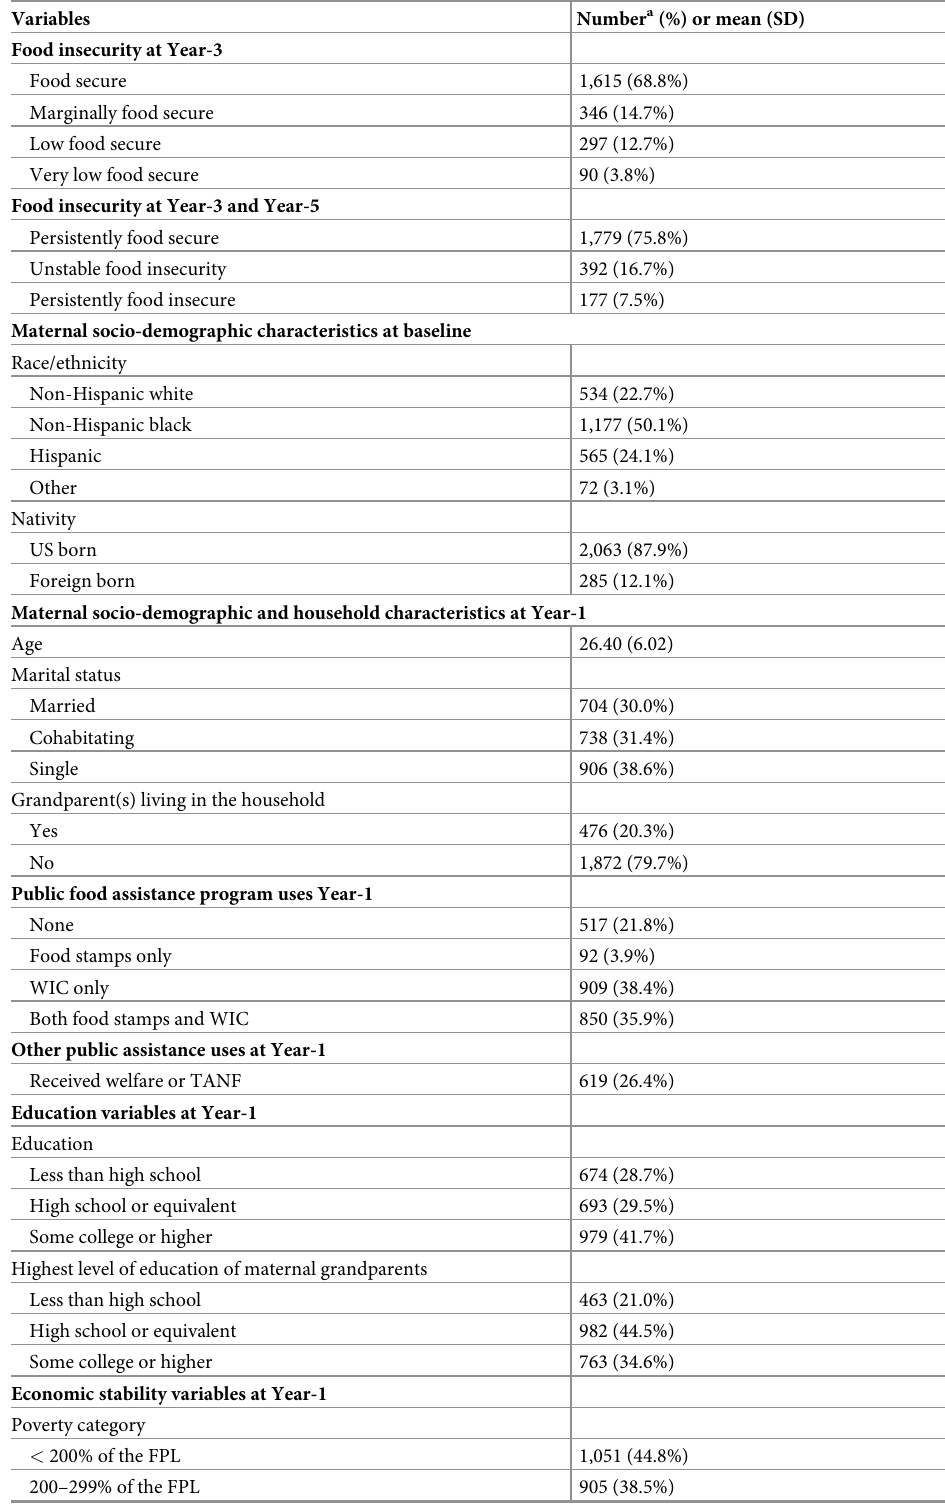
Table 1. Characteristics of the total study sample (n =